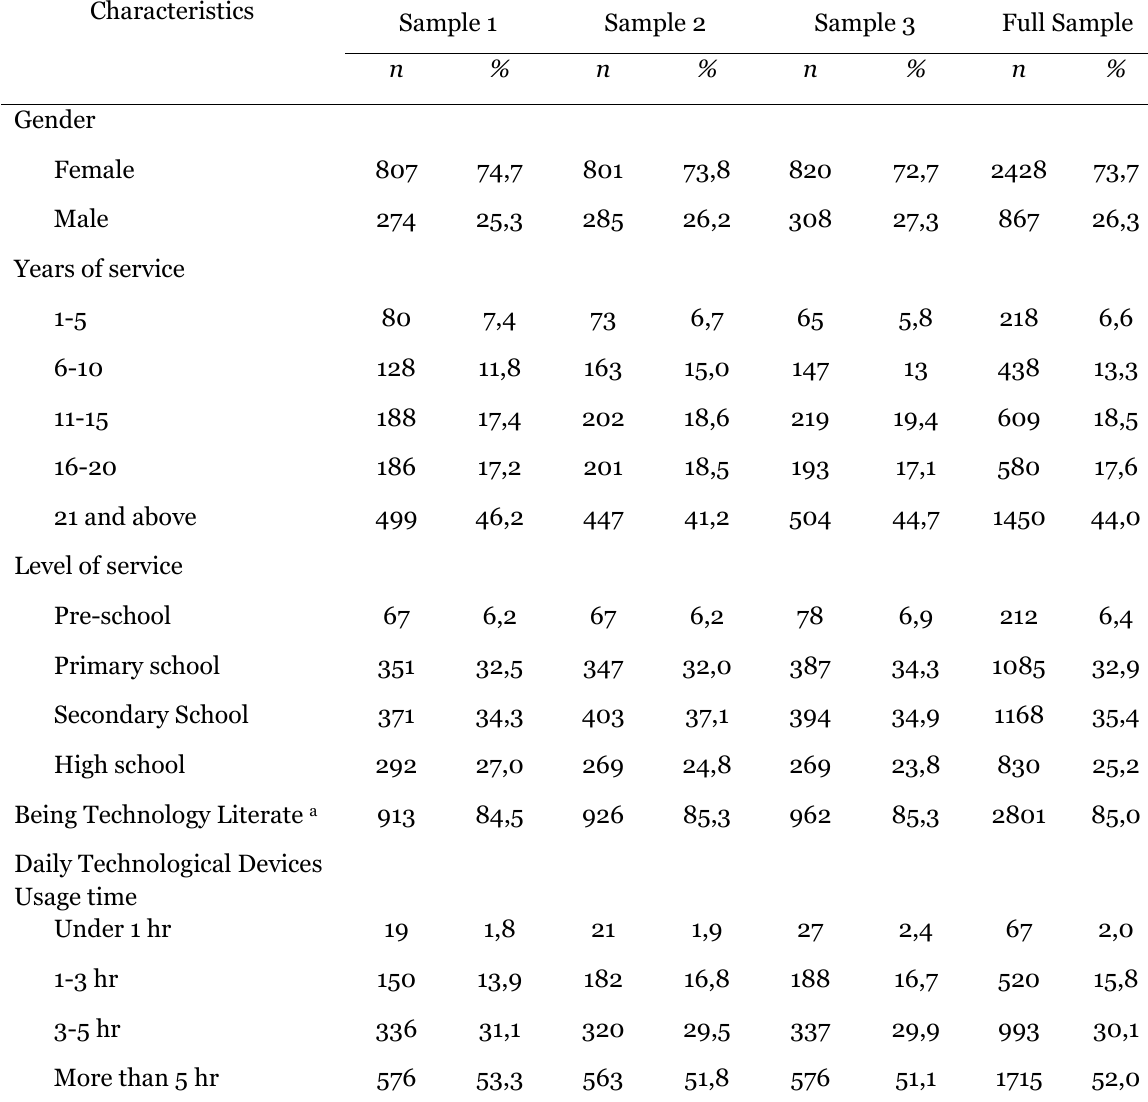
Demographic Characteristics of